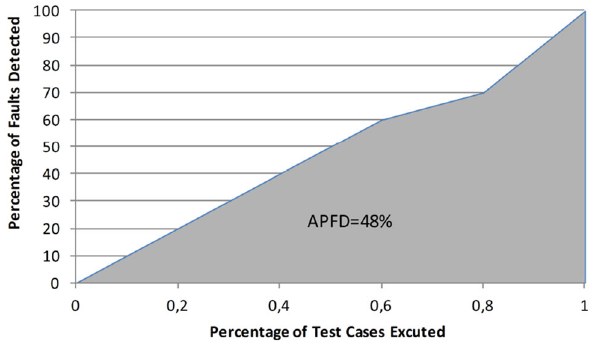
Fig. 8 Complexity-fault analysis of ant colony optimization (Spear- man r